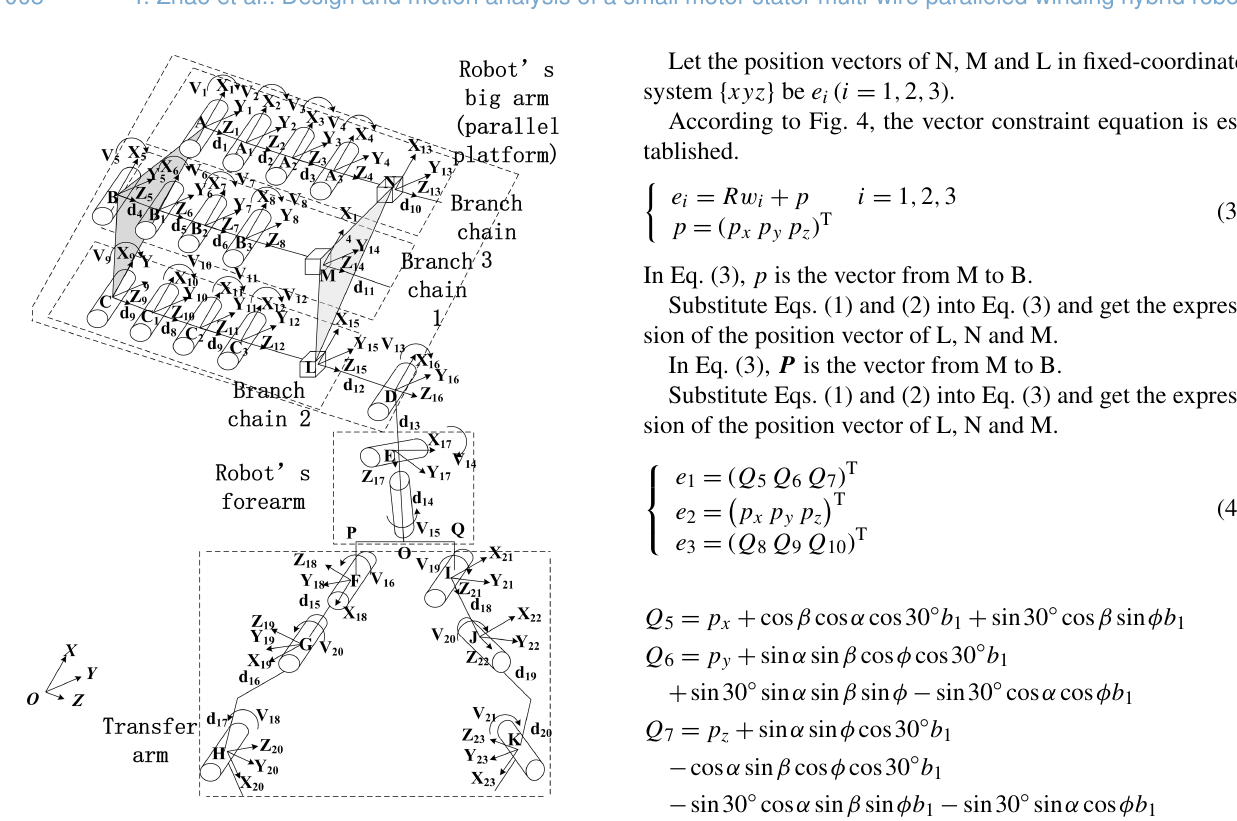
Figure 4. Motion model of winding